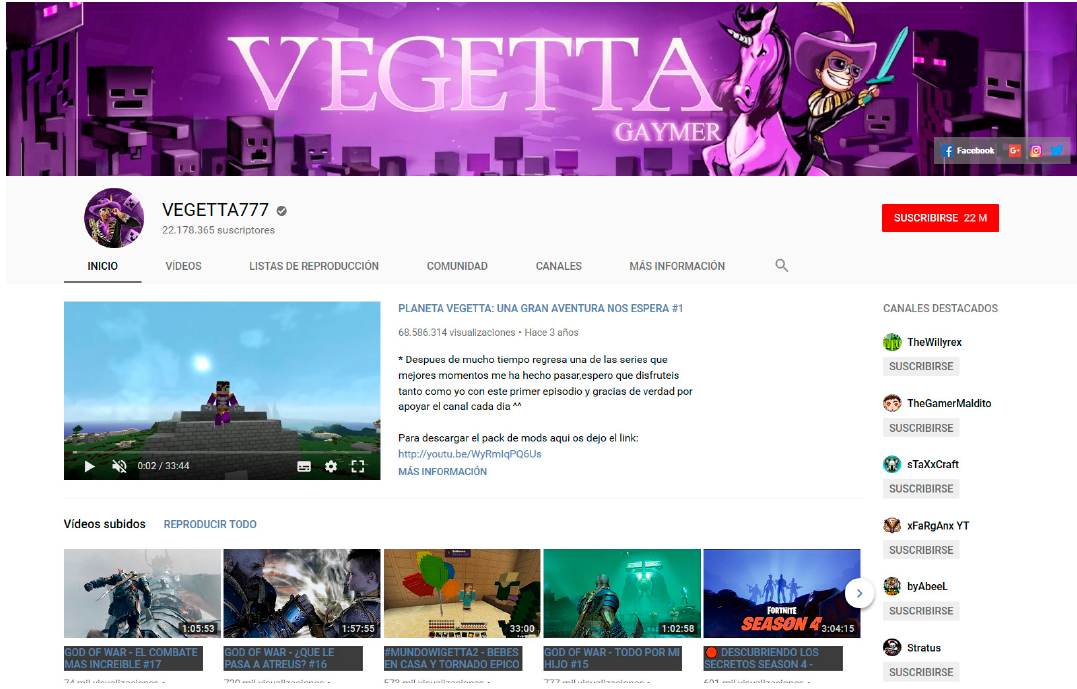
Figure 7. Front page of the YouTube channel VEGETTA777.